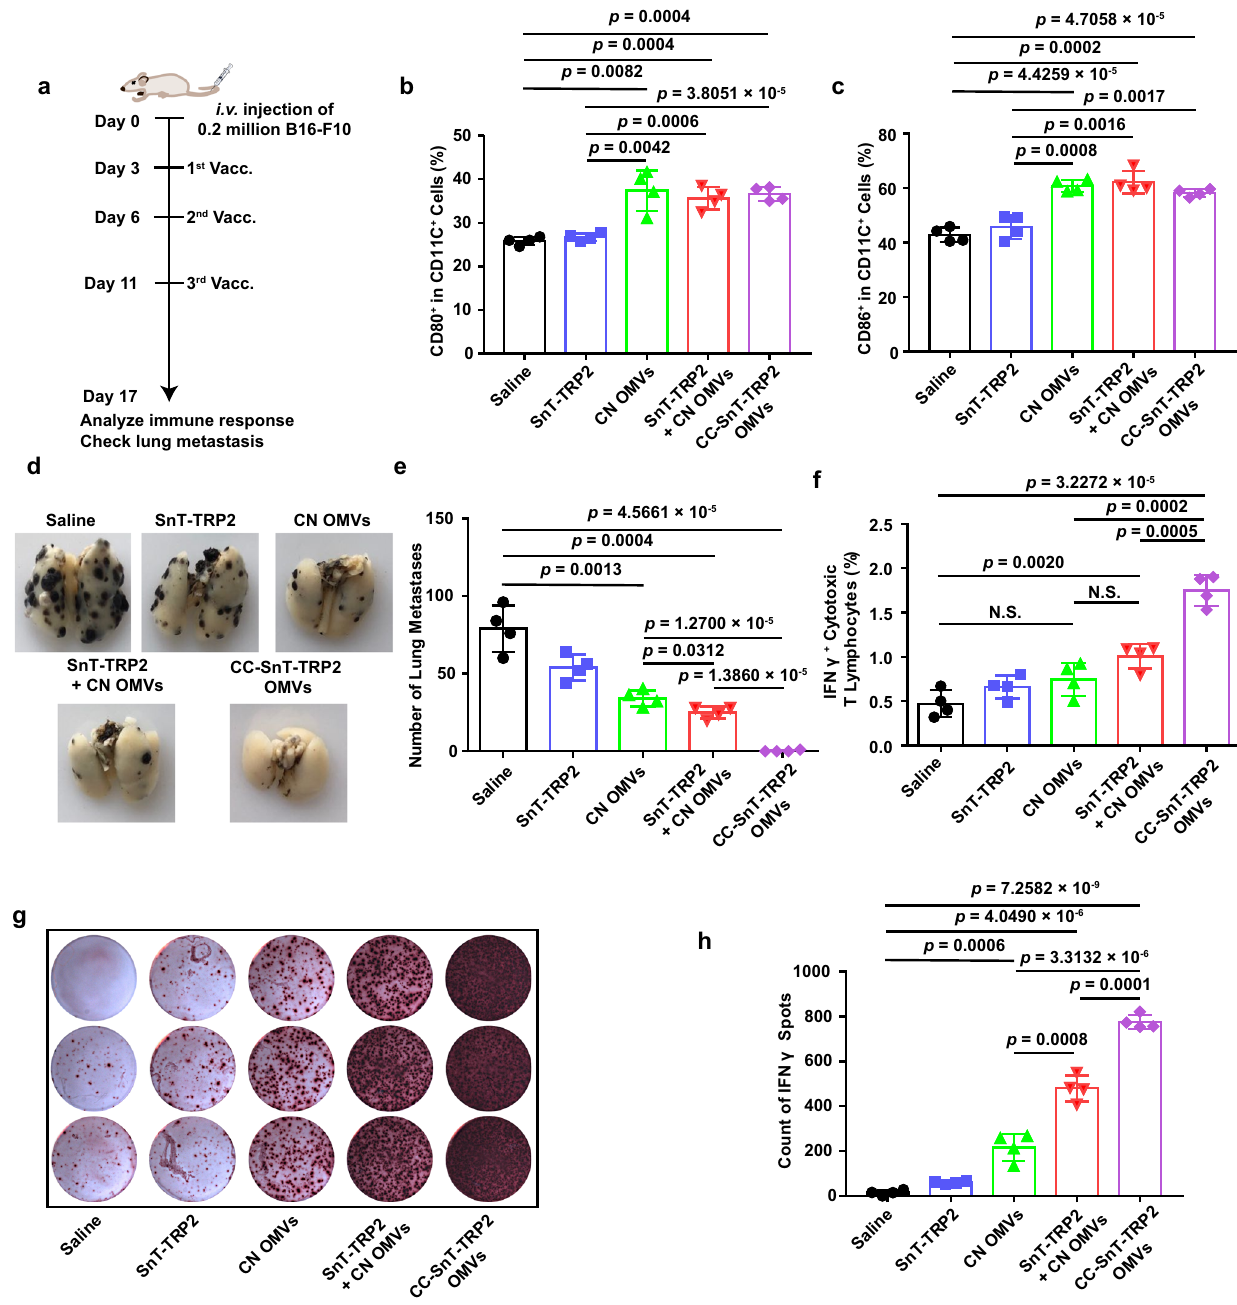
Fig. 4 Single-tumor antigen (TRP2 180 – 188 ) display by catcher-decorated OMVs. a Schema showing the B16-F10 melanoma lung metastasis mouse model and the OMVs vaccination (Vacc.) timeline. C57BL/6 mice were inoculated with B16-F10 melanoma cells ( n = 4, 2 × 10 5 cells/mouse, i.v.), then immunized with the following vaccines or controls: saline; SnT-TRP2; CN OMVs; SnT-TRP2 + CN OMVs; or CC-SnT-TRP2 OMVs on days 3, 6, and 11 after inoculation of the tumor cells. Lung metastasis and immune responses were analyzed on day 17. TRP2: tyrosinase-related protein 2. b , c Analysis of DC maturation in inguinal lymph nodes at the end of the treatment period (day 17). The percentage of CD80 + ( b ) or CD86 + ( c ) cells in CD11c + cells was determined by fl ow cytometry. d , e Lungs were collected at the end of the treatment period and photographed ( d ), then the tumor nodules in the lung were counted ( e ). f Flow cytometry analysis of IFN γ + cytotoxic T lymphocytes in splenocytes re-stimulated with TRP2 180-188 antigen. The percentage of IFN γ + cells in the CD3 + CD8 + T-cell subpopulation is shown. g , h IFN γ secretion from splenocytes (as determined by the ELISPOT assay) which had been re-stimulated with TRP2 180 – 188 ( g ). Quantitative analysis of the ELISPOT data is shown in ( h ). The data ( b , c , e , f , h ) are shown as mean ± SD. Statistical analysis was performed by a two-tailed unpaired t test. N.S. no signi fi cance. Source data are provided as a Source Data fi